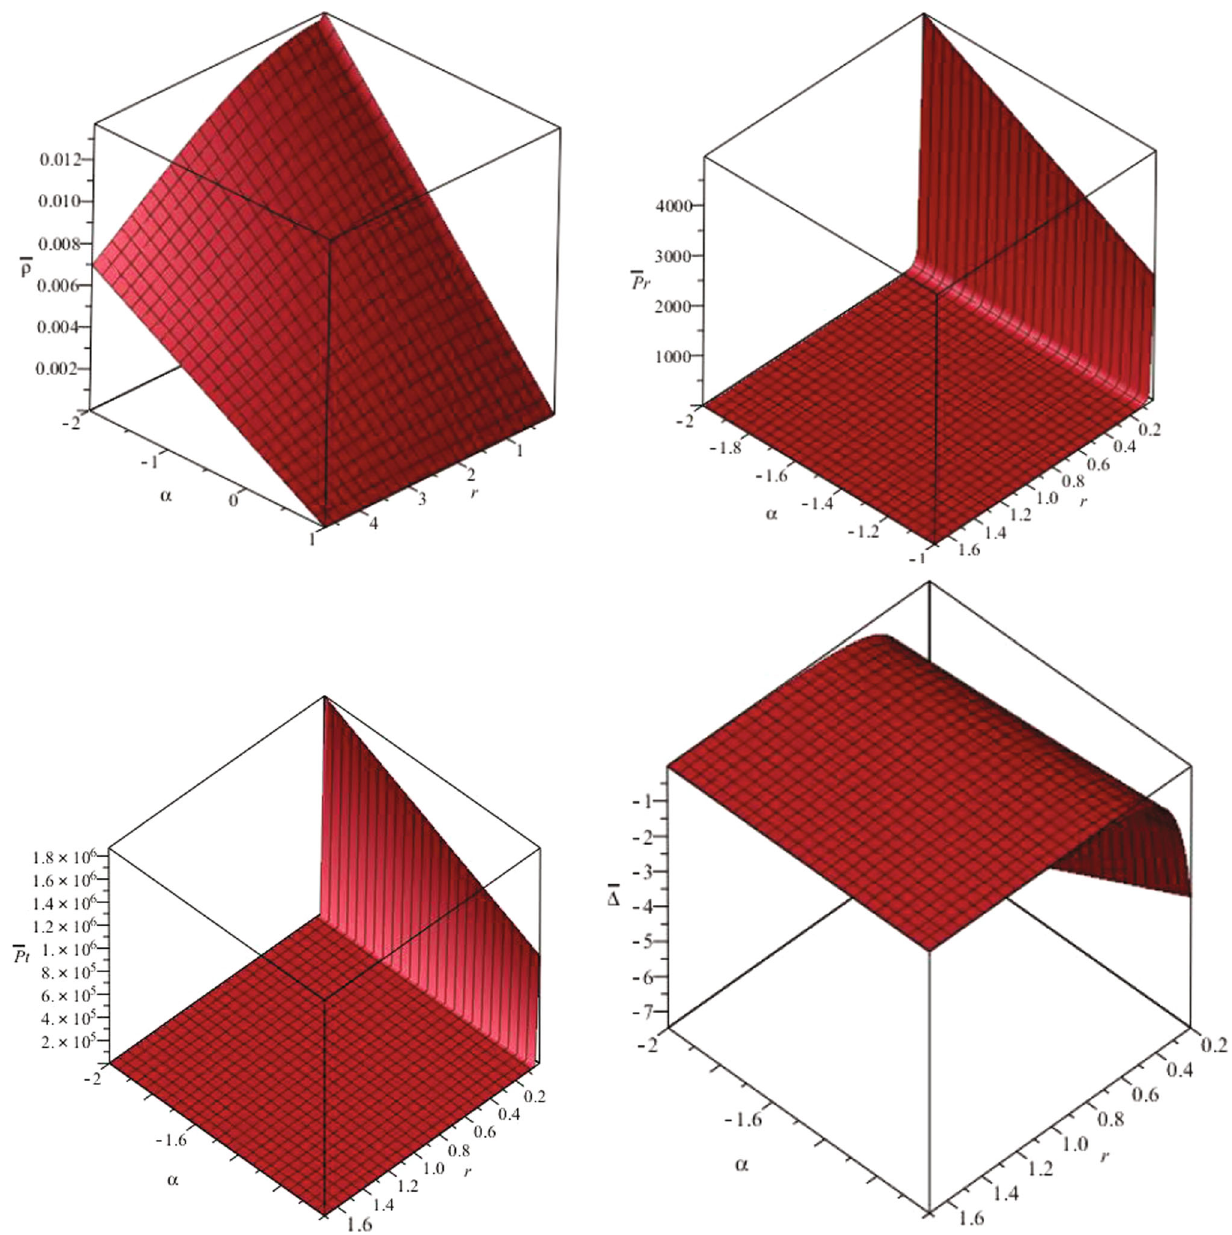
Fig. 4 Plots of ¯ ρ (left plot, row-1), ¯ P r (right plot, row-1), ¯ P t (left plot, row-2) and ¯ (cid:14) (right plot, row-2) against r and α using M 0 = 1 M (cid:9) and R = ( 0 . 3 ) − 1 M (cid:9) for solution-II